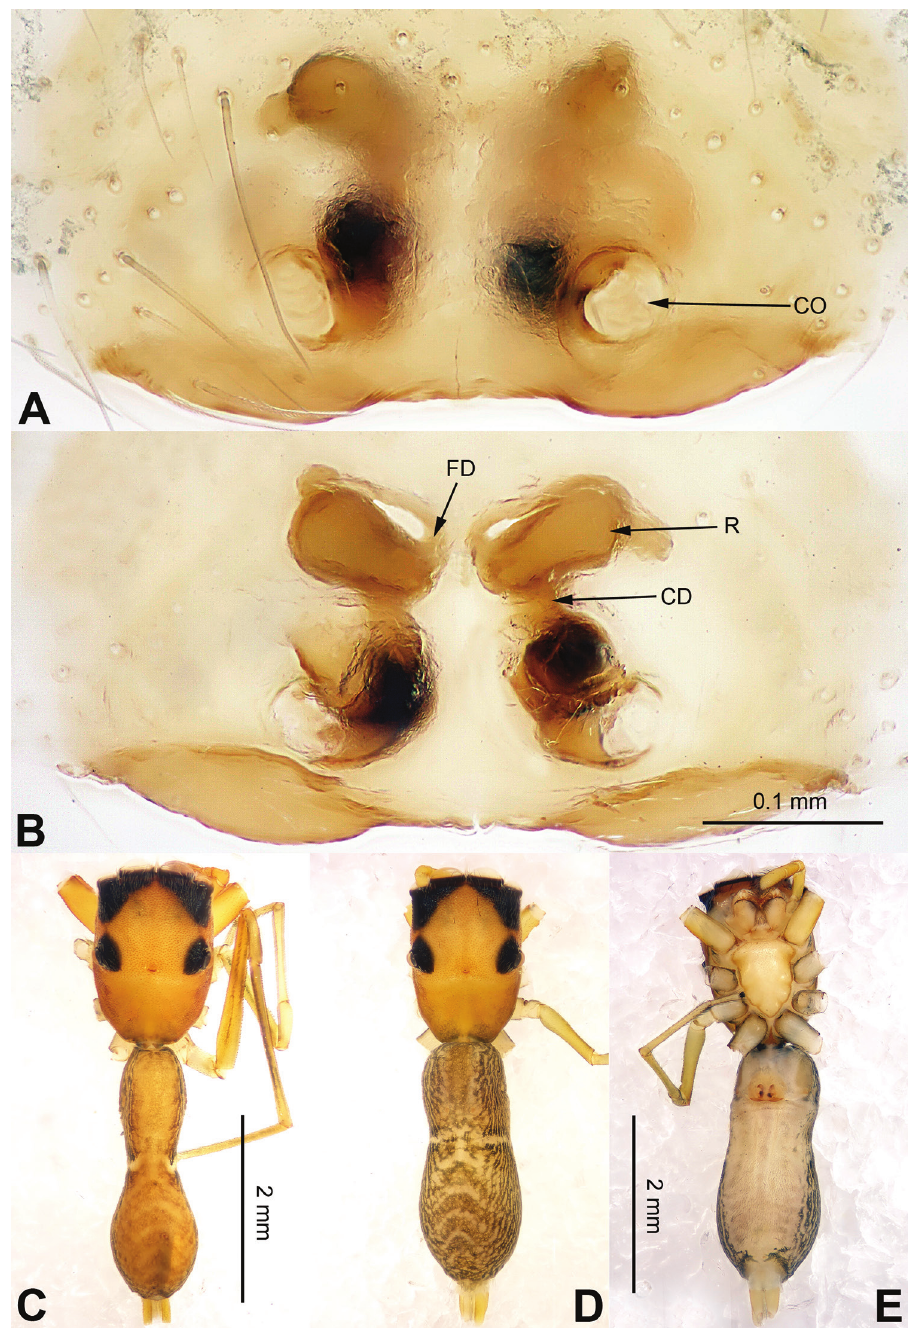
Figure 4. Agorius tortilis sp. n., female paratype and male holotype. A epigyne, ventral B vulva, dorsal C male habitus, dorsal D female habitus, dorsal E female habitus, ventral. Scale bar equal for A and B ; equal for D and E